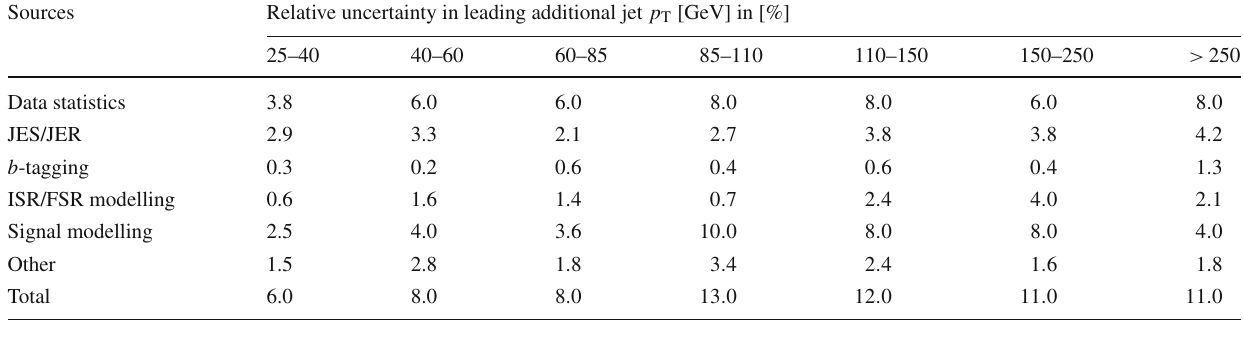
Fig. 7 Ratios of jet p T distribution for a leading b -jet, b sub-leading b -jet and c leading additional jet predicted by various MC generators to the unfolded data. The shaded regions show the statistical uncertainty ( dark grey ) and total uncertainty ( light grey